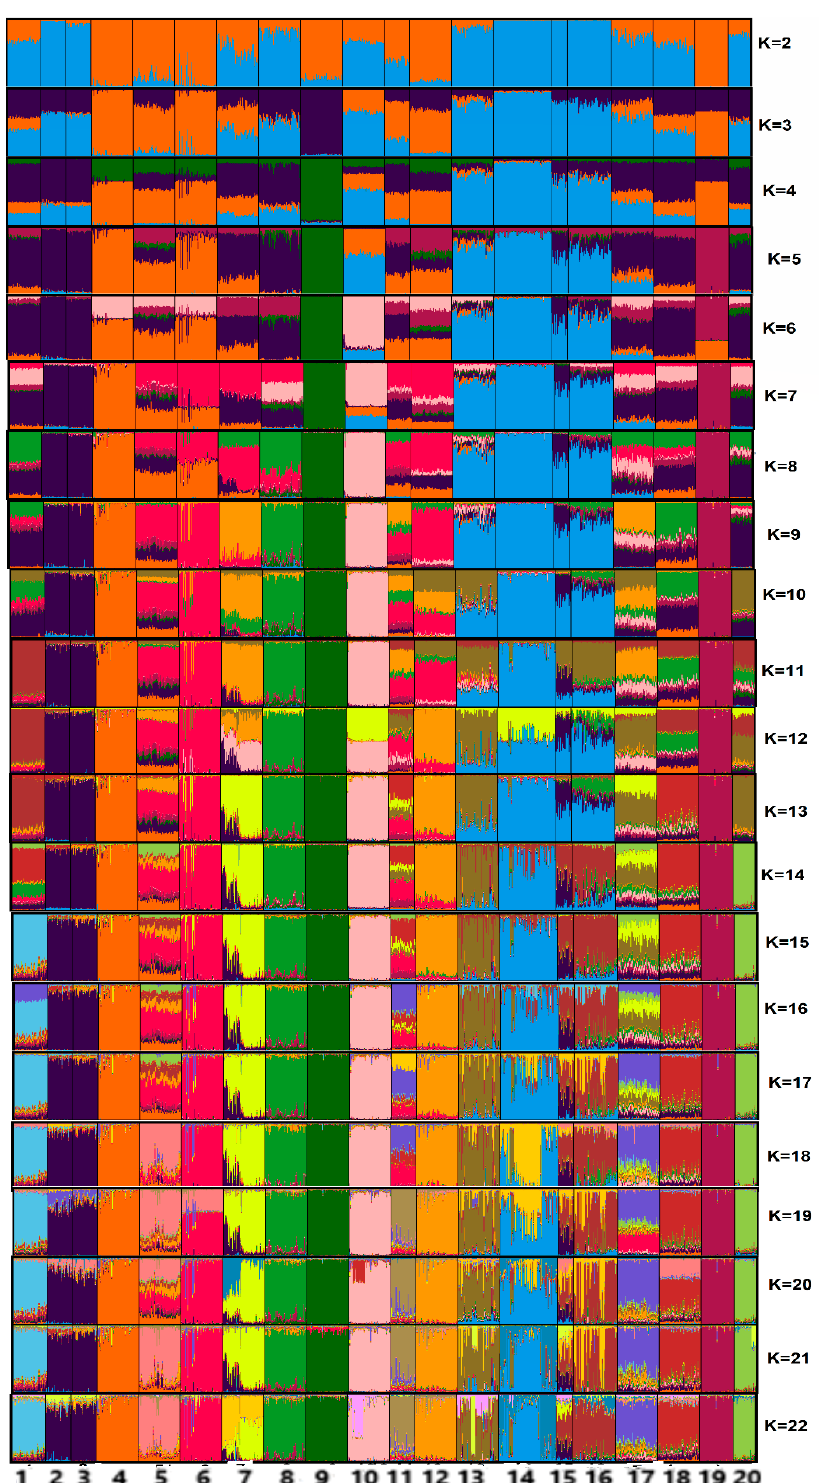
Figure 5. Analysis of population structure using the STRUCTURE software with 886 individuals representing the 20 groups of chicken studied (18 native breeds and two commercial strains) based on 25 microsatellite markers. 1, Canela-Preta; 2, Caneluda do Catolé; 3, Peloco; 4, Andaluza Azul; 5, Castellana Negra; 6, Combatiente Español; 7, Extremeña Azul; 8, Ibicenca; 9, Mallorquina; 10, Pita Pinta; 11, Sureña; 12, Utrerana Perdiz; 13, Amarela; 14, Branca; 15, Preta Lusitânica; 16, Pedrês Portuguesa; 17, Araucana; 18, Nigerian chicken; 19, Leghorn strain; 20, Cornish strain.